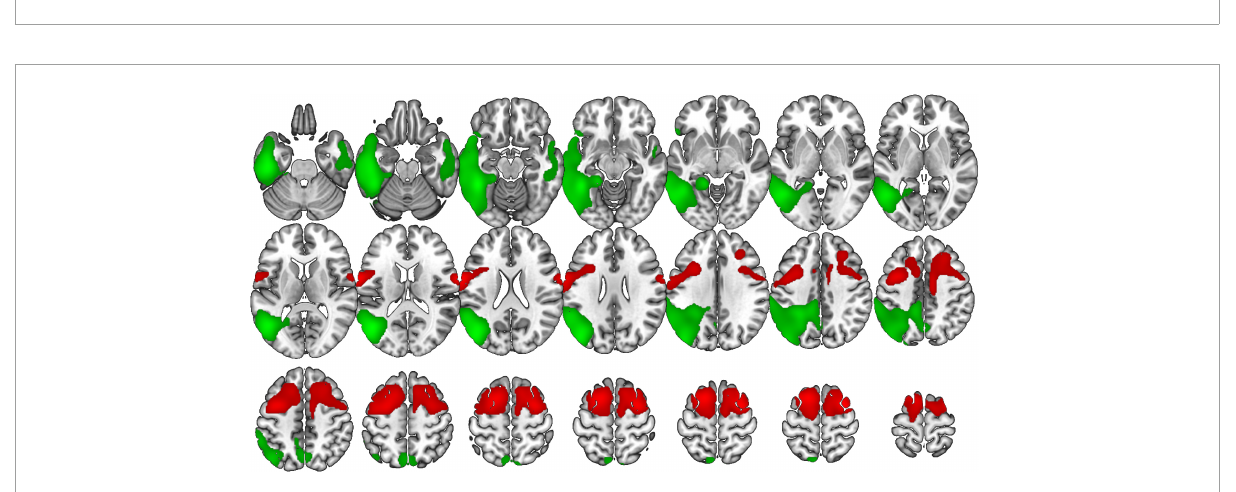
FIGURE4 Voxel-based brain mapping analysis showing the correlation between the VOSP-NL and brain metabolism in bvFTD (red) and AD (green) (FWE-cluster corrected p -value < 0.05). Images are shown in neurological orientation.